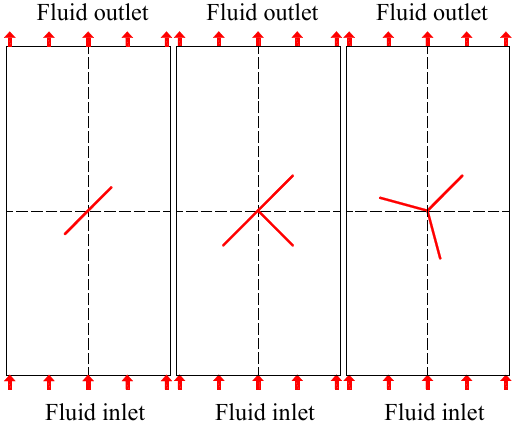
Figure 6. Two ‐ dimensional numerical model diagram. Figure 6. Two-dimensional numerical model